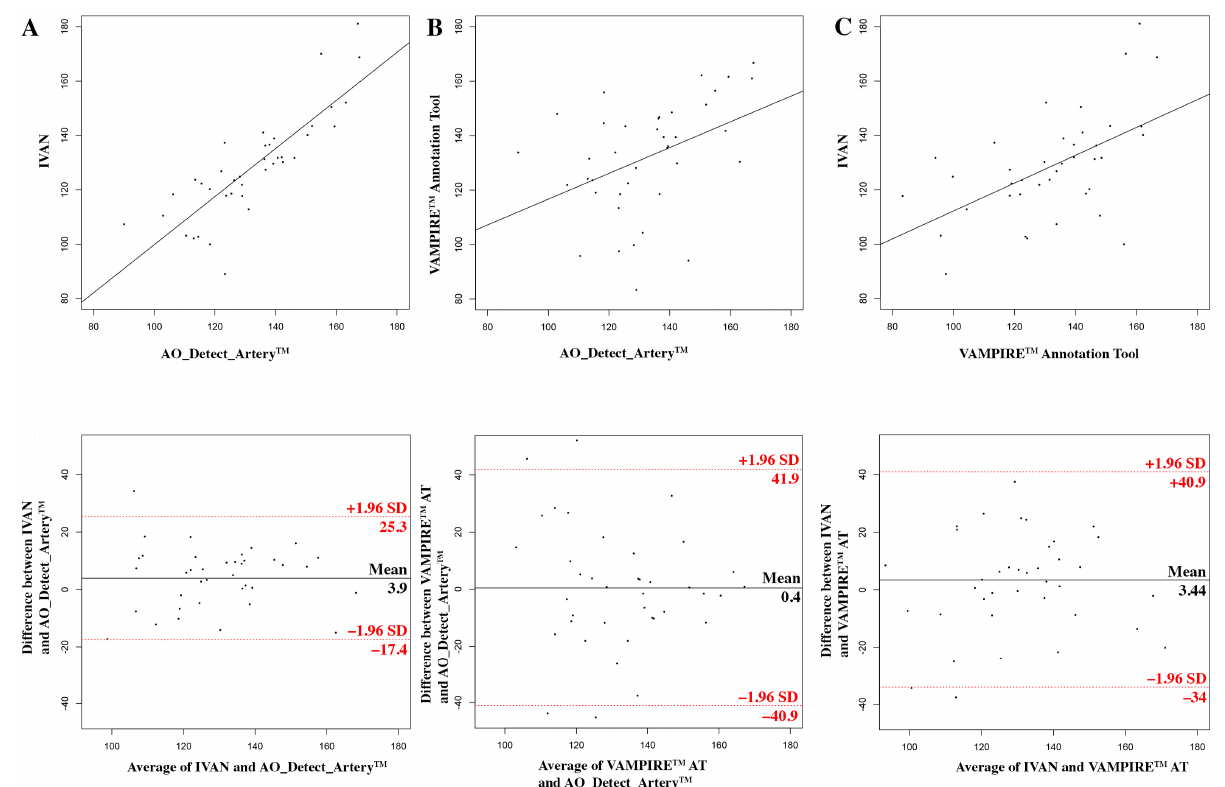
Figure 4. Measurements of retinal vein lumens using AO and fundus camera images. Top row: scatter plots of vessel diameter measurements with the result of the Pearson correlation tests. Bottom row: Bland–Altman plots (see axis labels for measures, where compared). The top and bottom lines visualize the 95% limits of agreement (2SD) ( A ) using the AO_Detect_Artery™ software on AO image vs. IVAN software on fundus image; ( B ) using the AO_Detect_Artery™ software on AO image vs. VAMPIRE AT (annotation tool) on fundus image; ( C ) using IVAN software vs. VAMPIRE AT on fundus image.